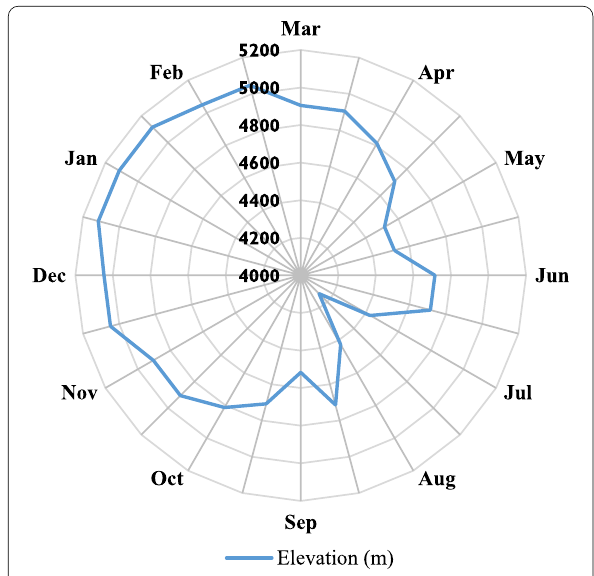
Fig. 4 Elevation profile of the Dokpa route ranging from 4100 to